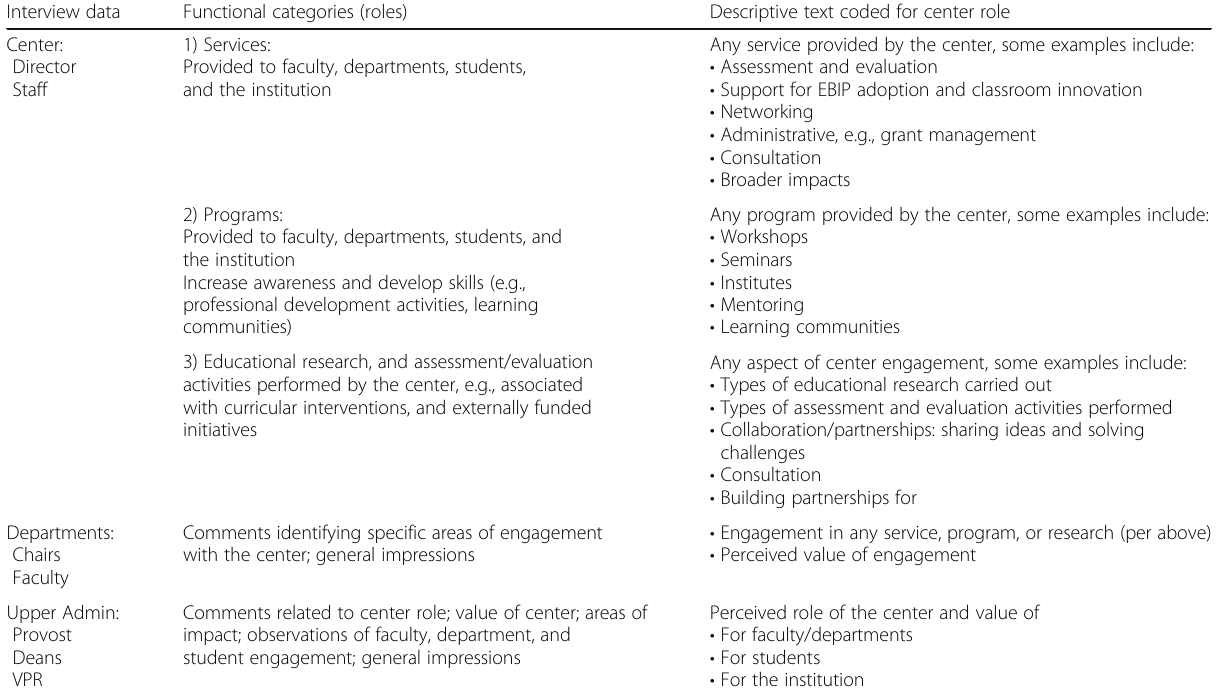
Table 3 Coding categories and